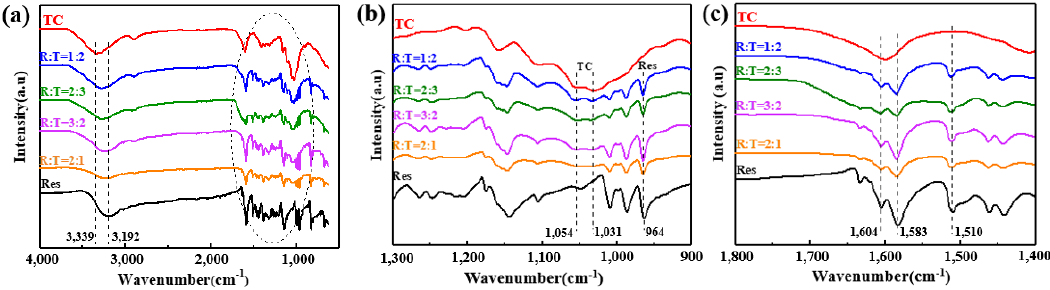
Figure 5. FTIR ( a ) full spectra, ( b ) zoom-in spectra in the band between 1300 to 900 cm − 1 , and ( c ) zoom-in spectra in the band between 1800 to 1400 cm − 1 of the TC aerogel, Res, and RLTAs.